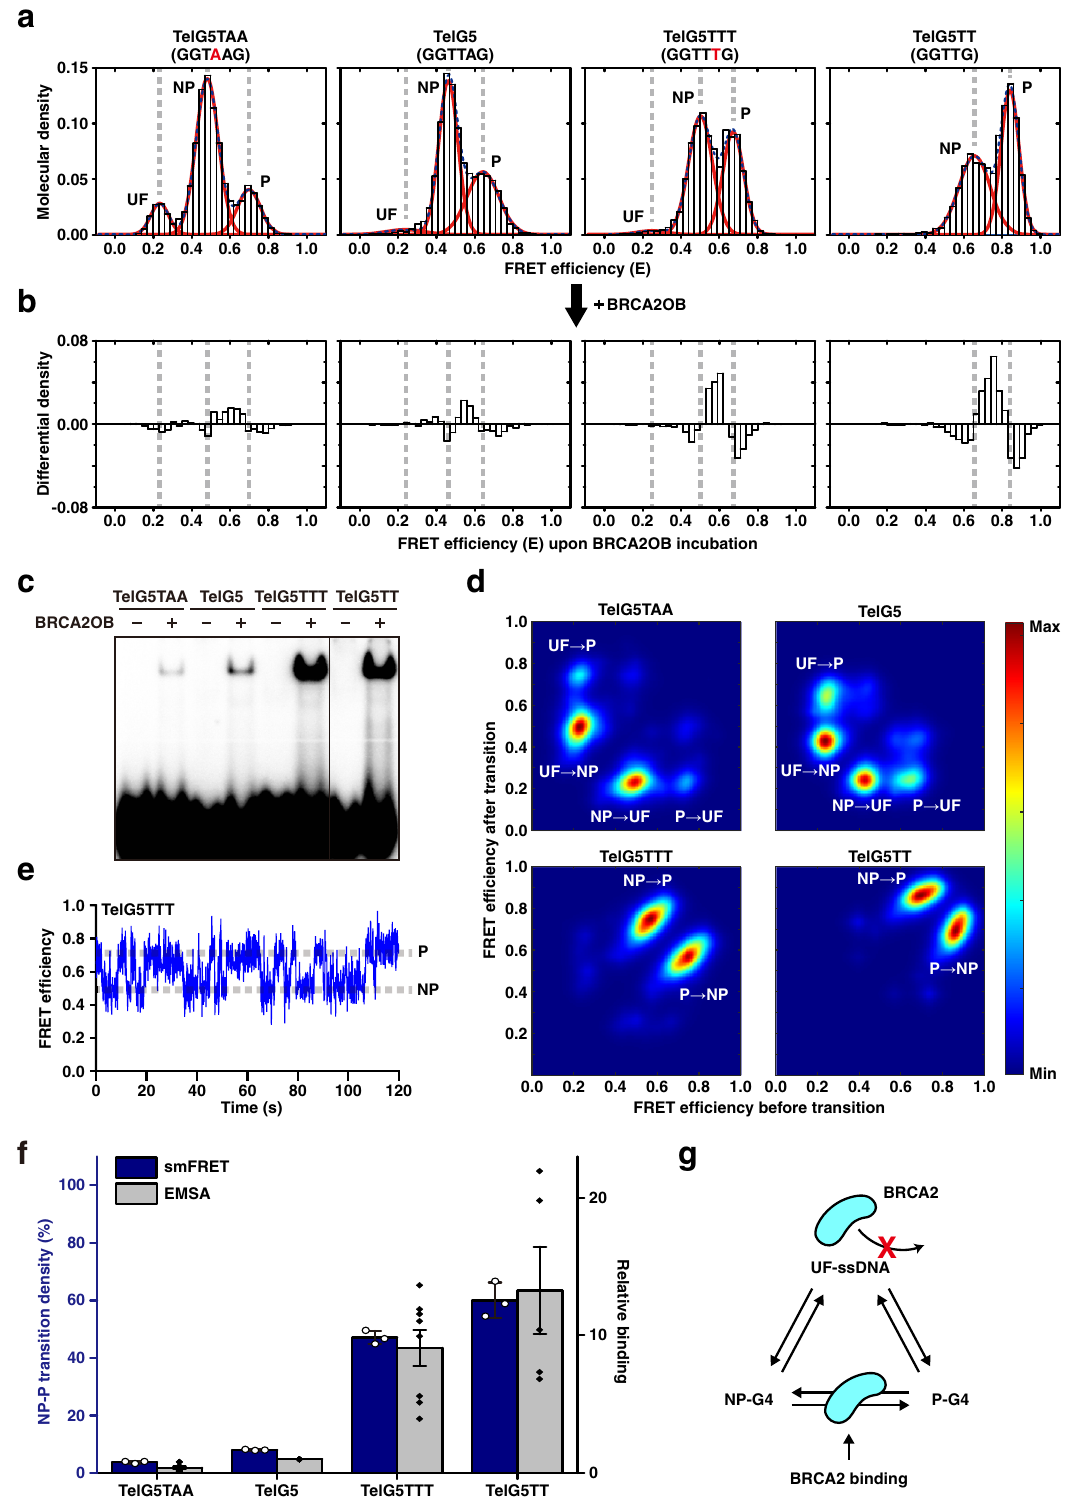
TelG5, BRCA2OB binding was increased by 3-fold for TelG5-G3 and 9-fold for TelG5TTT (Fig. 4e). These results suggest that BRCA2 associates with the G4 substrates primarily through selective interaction with the G-triplex-derived intermediates, which can form during the NP-P conformational interconver- sions (Fig. 4f, box with broken line). The NP-P conversion via UF-ssDNA (Fig. 4f, lower, unboxed) may also involve the